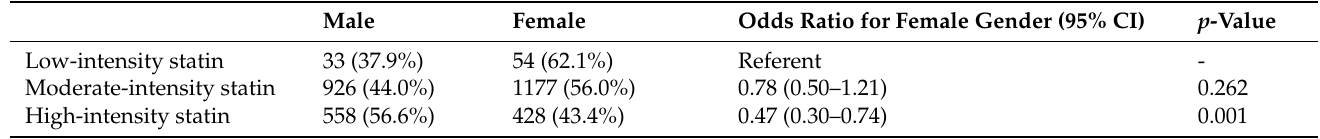
Table A4. Analyses of statin intensity by